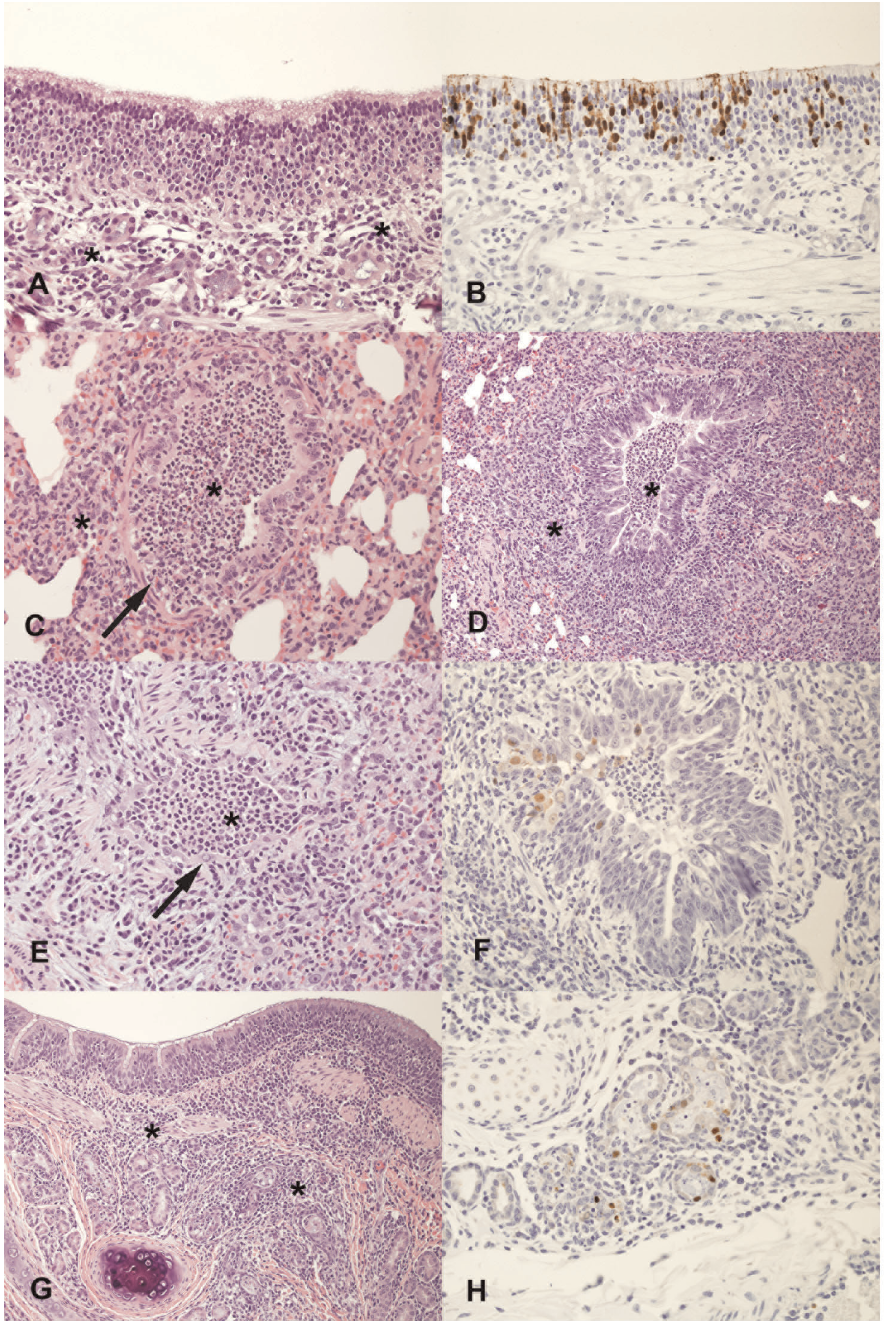
Figure 2. Histopathologic lesions and influenza antigen localization in ferrets inoculated with wild bird influenza viruses. A) Nasal turbinates of ferrets inoculated with H6N1 or H1N9 demonstrated moderate submucosal inflammation (asterisk) (H1N9, d3pi). B) There is widespread strong intranuclear and some intracytoplasmic positive immunoreactivity for the nucleoprotein of influenza A on immunohistochemistry in ferrets inoculated with H6N1 or H1N9 on day 3 pi (H1N9, d3pi). C) Epithelial damage in the lung was early for ferrets inoculated with H1N9, with necrosis in the bronchioles (arrow) and inflammation (asterisks) within and around bronchioles on day 2 pi. D and E) There was evidence of early repair with regeneration of bronchiolar epithelium (arrow) and persistence of inflammation (asterisks) on day 3 pi for ferrets inoculated with H6N1 and H1N9 (H1N9, d3pi). The arrow highlights the stretched and plump bronchiolar epithelial cells, indicating regeneration. F) Presence of influenza antigen was confirmed in ferrets inoculated with H6N1 and H1N9 by strong positive intranuclear staining of bronchiolar epithelial cells with immunohistochemistry on day 3 pi (H6N1, d3pi). G) Inflammation around larger airways in the lung was also present in ferrets inoculated with H6N1 and H1N9, with prominent periglandular bronchial inflammation (asterisk) (H6N1, d7pi). H) There was strong positive intranuclear staining for the nucleoprotein of influenza in the peribronchial glandular epithelial cells on immunohistochemistry on day 3 pi in ferrets inoculated with H6N1 and H1N9 (H1N9, d3pi).